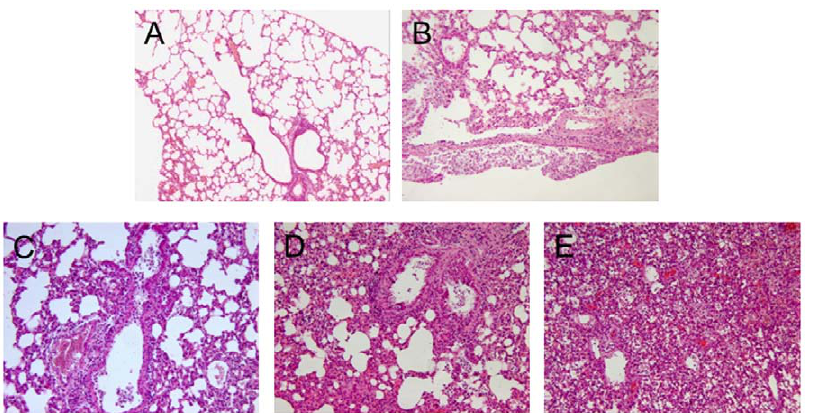
Figure 4. Histological analysis of the lung tissues. The collected lung tissue samples from each group of mice at 4 d.p.i. were subjected to routine histological process and the tissue sections were stained with H&E. Data show are representative images (magnification 6 100) of each group of mice (n=10 per group). (A) The lung tissue section from PBS mock infected mice; (B) The lung tissue section from the mice infected with WT virus; (C) The lung tissue section from the mice infected with MA-2 virus; (D) The lung tissue section from the mice infected with MA-3 virus; (E) The lung tissue section from the mice infected with MA-8 virus.